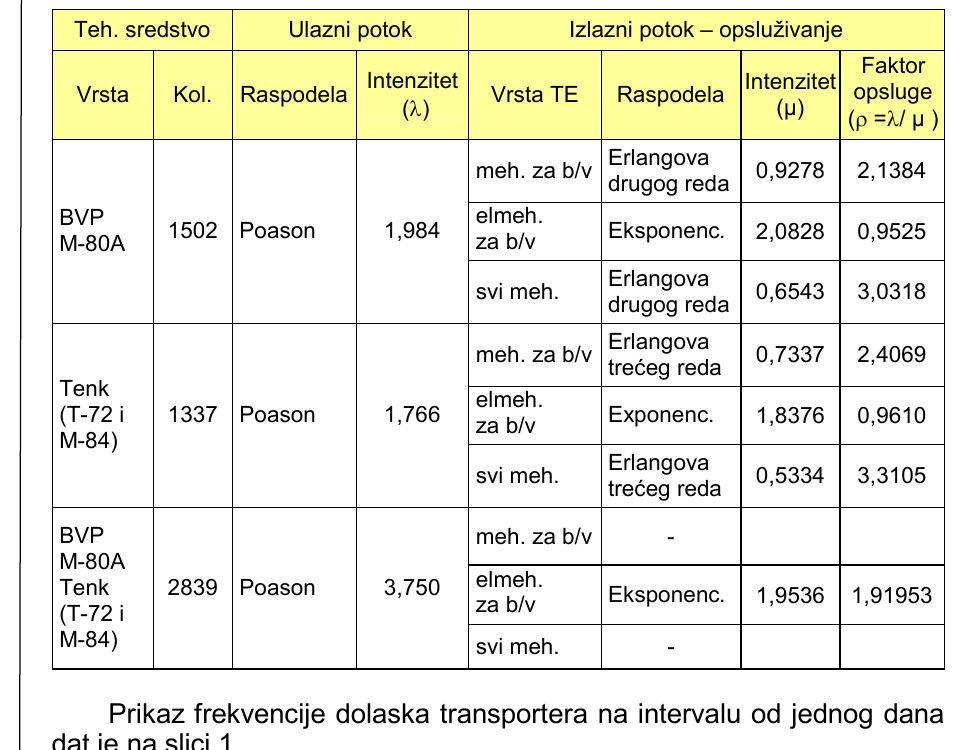
Input and output stream of the